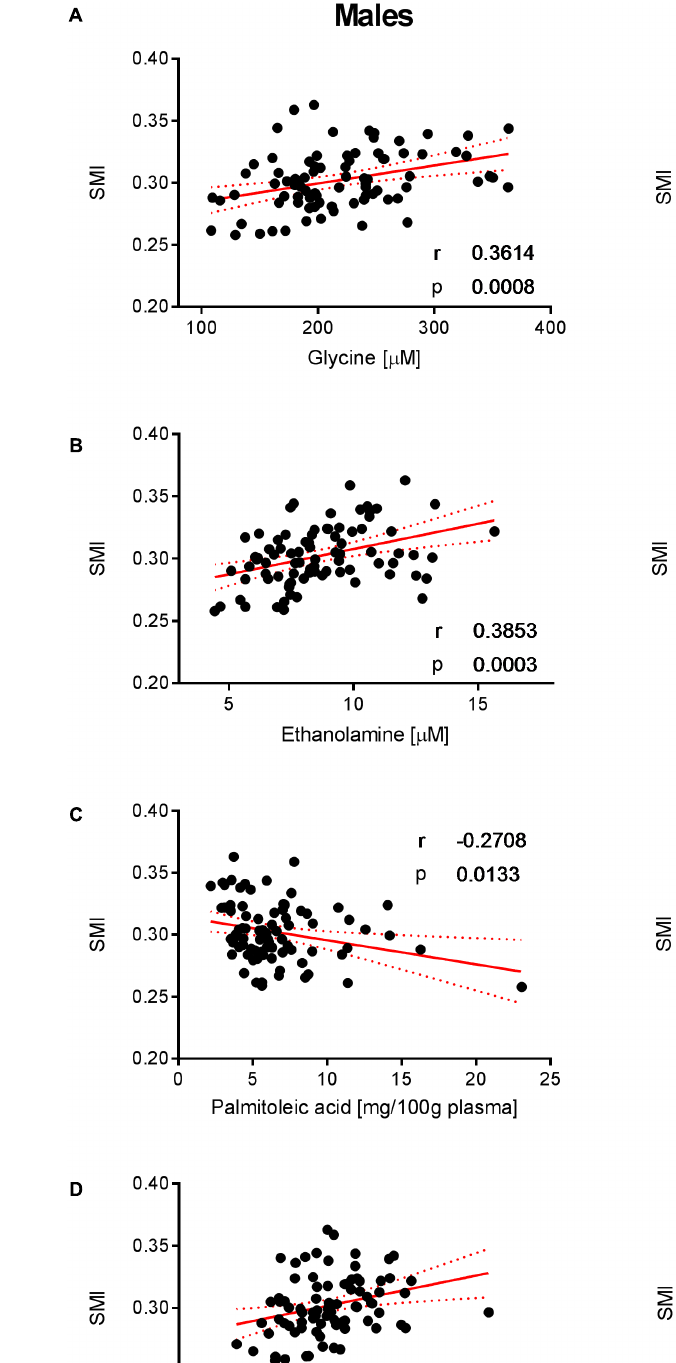
Frontiers in Physiology |